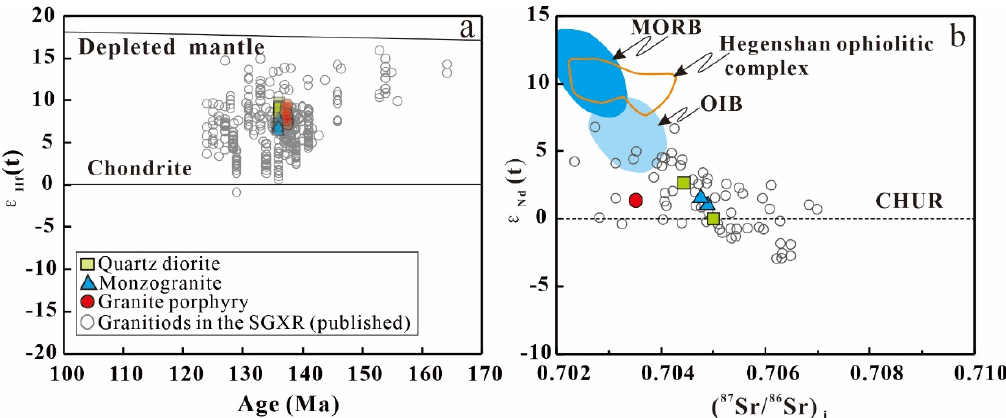
Figure 5. ( a ) Zircon U–Pb age versus ε Hf (t) diagrams for the granitoids from Zalute; ( b ) Sr–Nd isotope diagrams for the granitoids from Zalute. Data sources are from previously published Sr–Nd–Hf isotopic data for the SGXR [9,17,18,27,58–60].